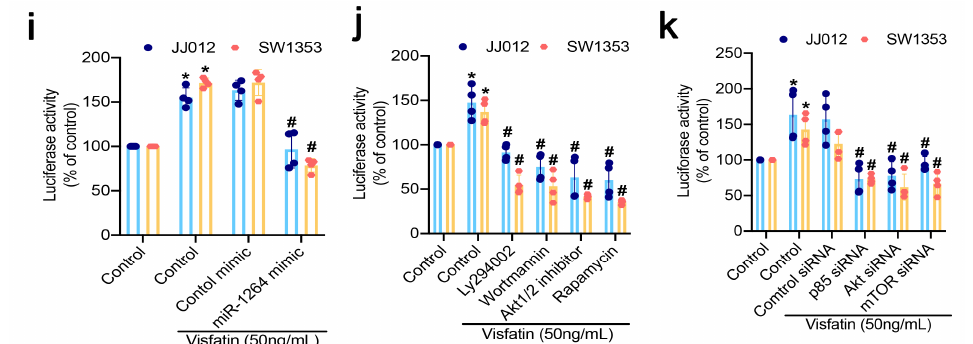
Figure 5. Inhibition of miR-1264 regulated visfatin-enhanced increases in PDGF-C expression of chondrosarcoma cells. ( a ) MiRNA target prediction software identified miRNAs that potentially bind to the PDGF-C 3 (cid:48) -UT; ( b ) chondrosarcoma cell lines were incubated with high-dose visfatin for 24h and miRNA expression was examined by qPCR; ( c ) both cell lines were incubated with visfatin for 24 h and miR-1264 expression was examined by RT-qPCR; ( d ) The cells were transfected with miRNAs, as indicated, before being incubated with visfatin for 24 h. PDGF-C expression was determined by qPCR; ( e , f ) chondrosarcoma cell lines were pretreated with pharmacologic inhibitors or transfected with siRNAs, as indicated, then stimulated with visfatin for 24 h. MiR-1264 expression was analyzed; ( g ) schematic 3 (cid:48) -UTR representation of human PDGF-C containing the miR-1264 binding site; ( h – k ) PDGF-C-3 (cid:48) -UTR luciferase plasmids containing the miR-1264 binding site were analyzed for luciferase activity. Quantitative results are expressed as means ± SD. Compared with the control group, * p -values < 0.05; compared with the visfatin-treated group, # p -values <